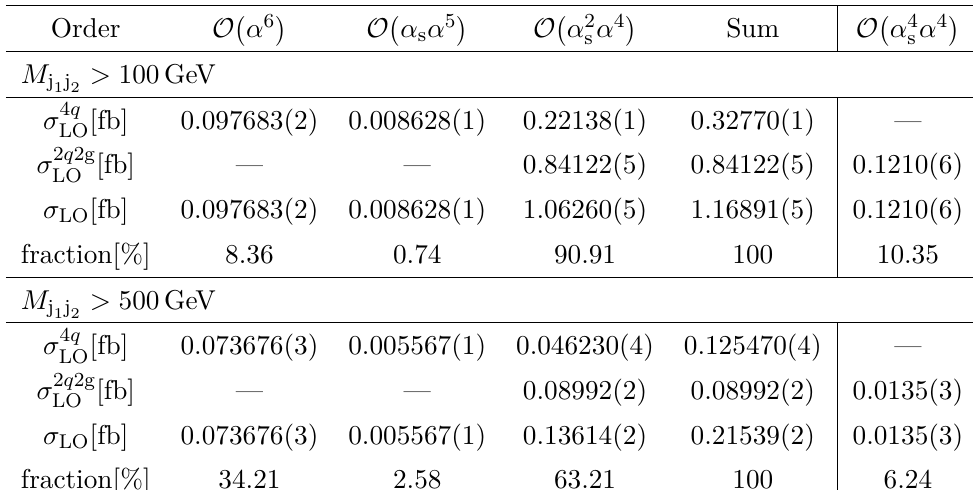
(cid:0) (cid:1) (cid:0) (cid:1) (cid:0) (cid:1) α 6 , O α s α 5 , O α 2 α 4 , and their sum s , are LO (cid:0) (cid:1) α 4 α 4 is also listed but does not s